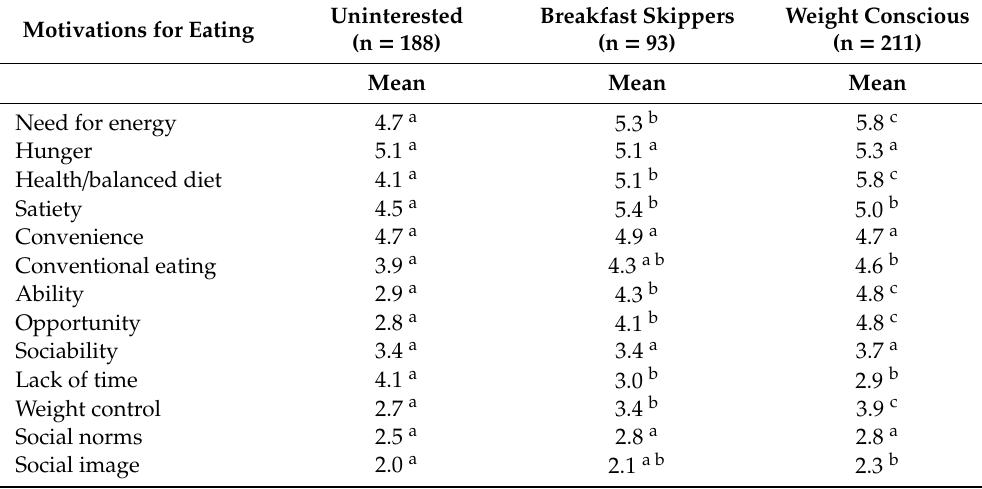
Table 5. Di ff erences in eating motivations between the